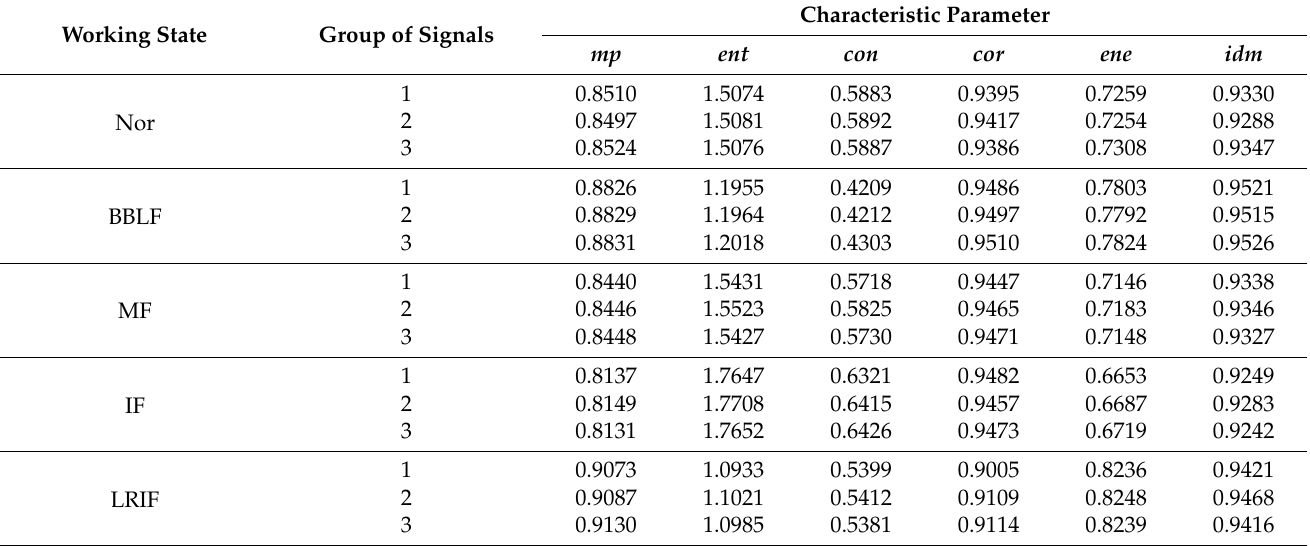
Table 6. Characteristic parameters of the rotor under different states.